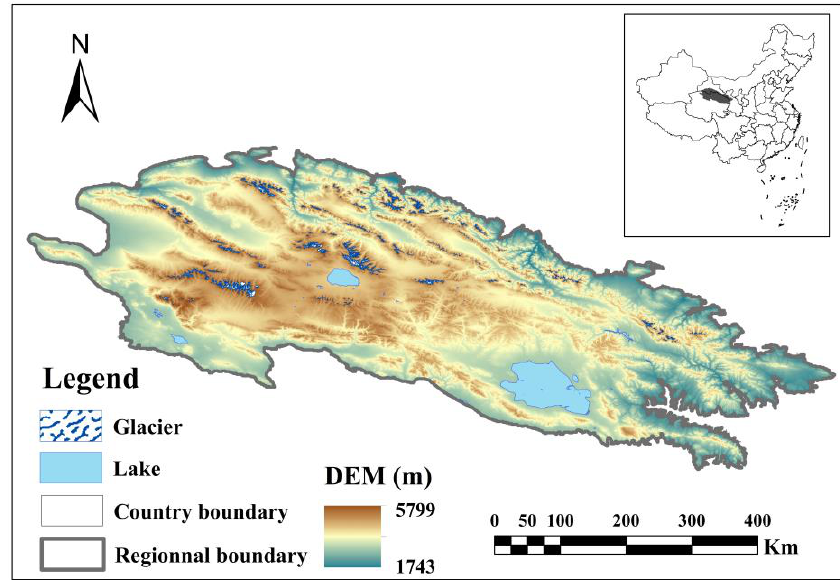
Figure 1. The location of the study area.